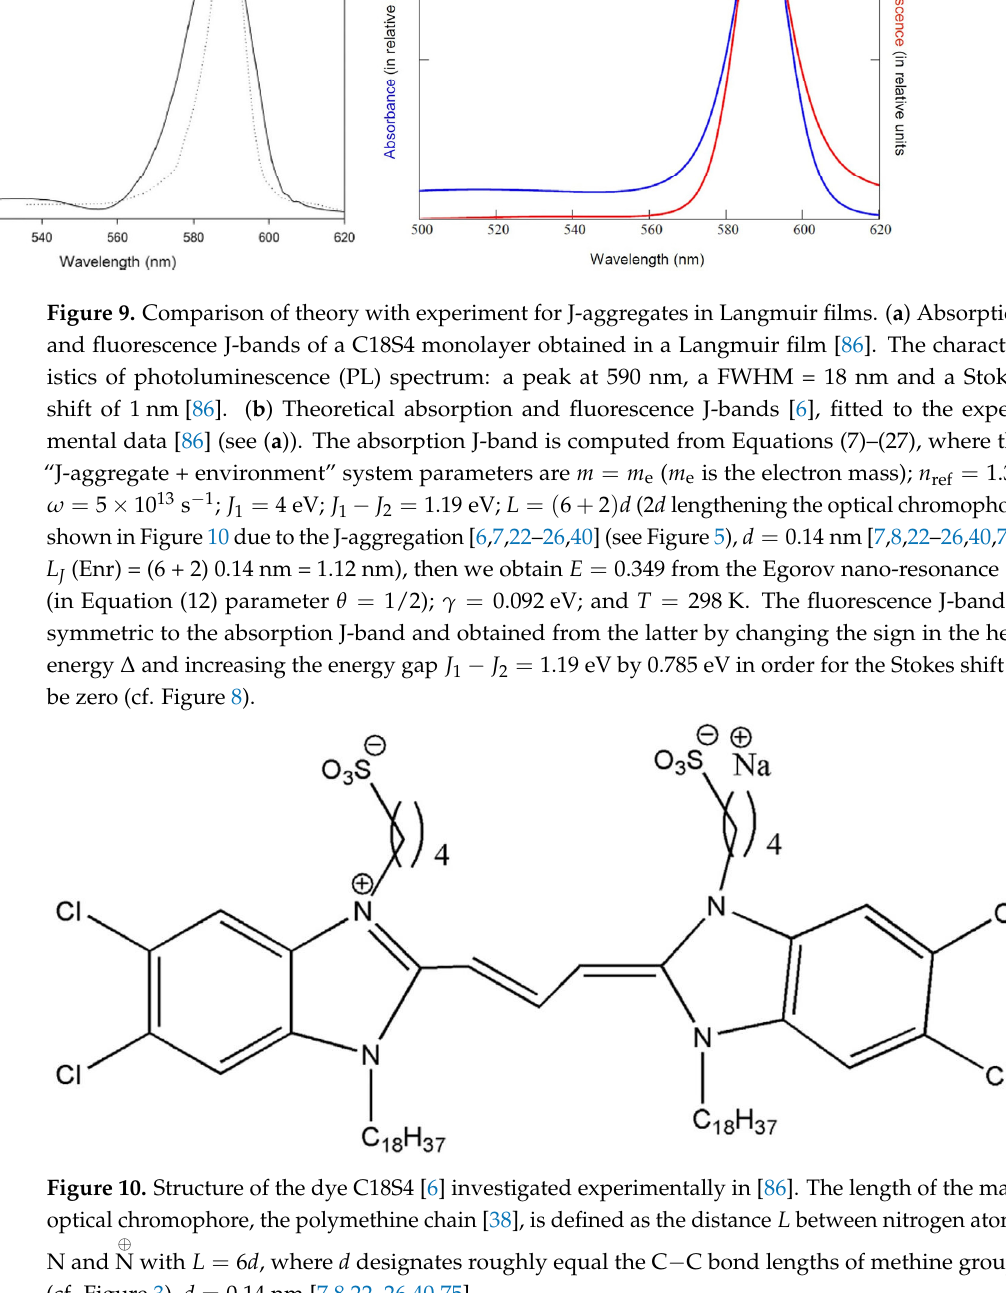
Figure 11. Comparison of theory with experiment for J-aggregates in Langmuir films. ( a ) Experi- mental absorption and fluorescence J-bands [86] shown in Figure 9a. ( b ) Theoretical absorption and fluorescence J-bands [6], fitted to the experimental data [86] (see ( a )). The fluorescence J-band is asymmetric to the absorption J-band and obtained from the latter by changing the sign both in the heat energy Δ and in the J-chromophore length